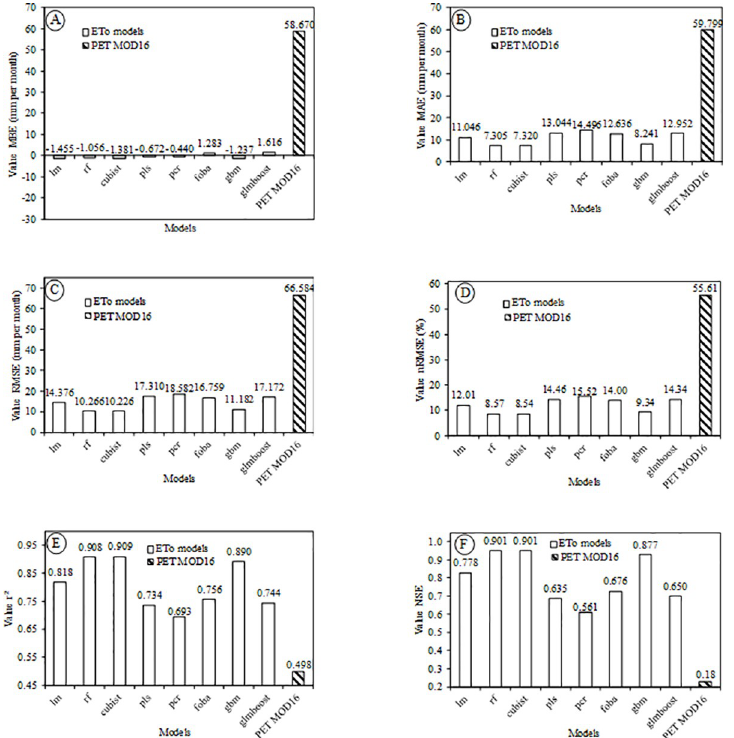
Fig 3. Results of the statistical indices used to evaluate the pre-selected models in comparison to the standard method (PM-FAO), (A) MBE, (B) MAE, (C) RMSE, (D) nRMSE, (E) r 2 and (F) NSE with out-of-sample data from the period